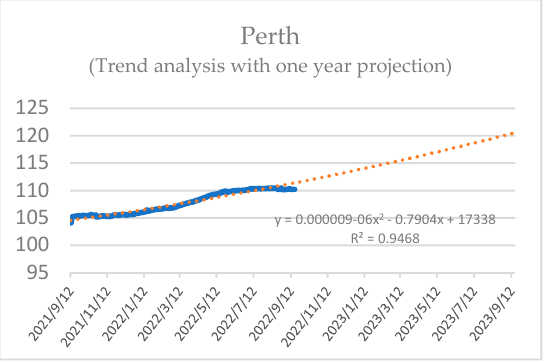
Figure 9. Trend analysis and one year prediction on housing prices for Perth.